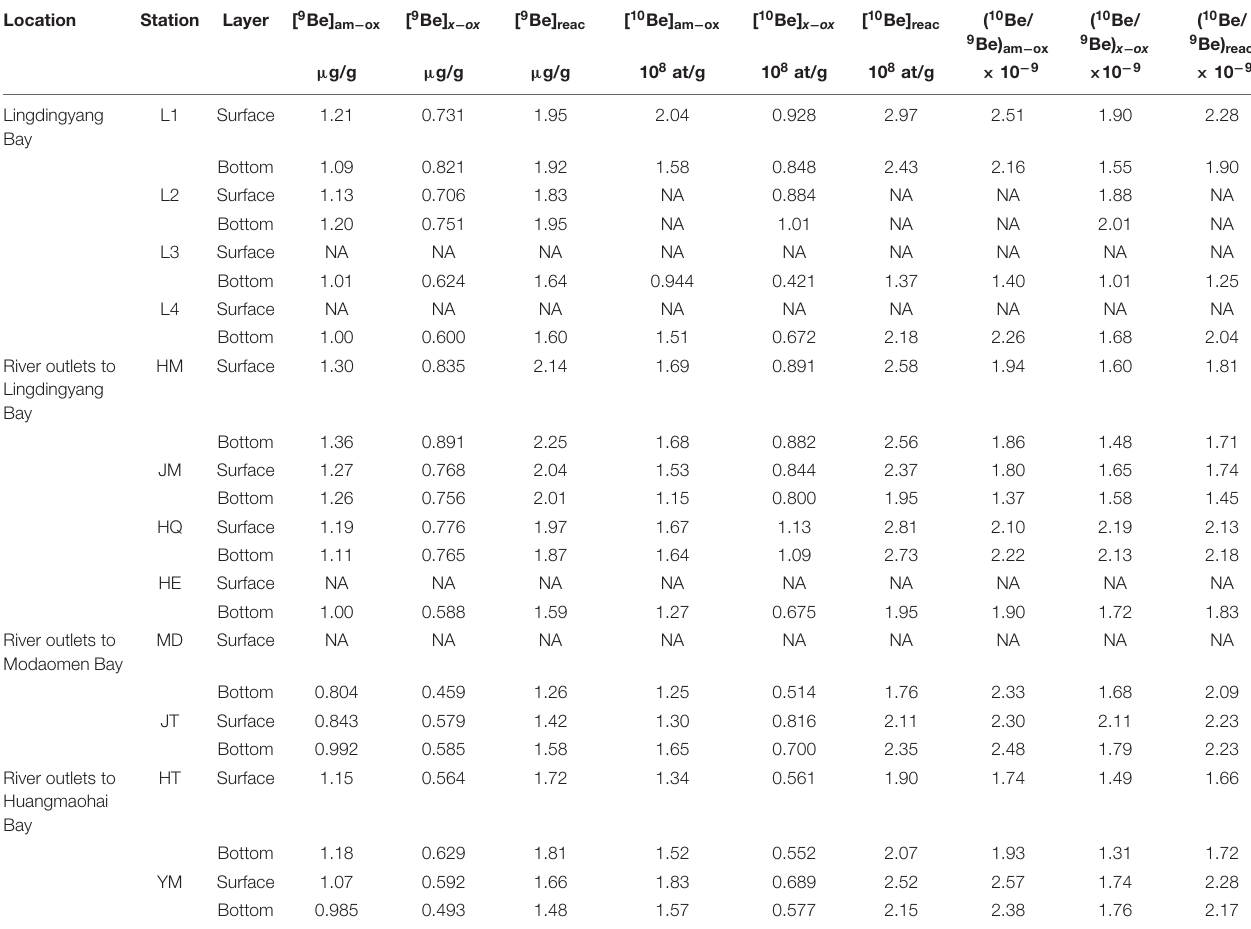
TABLE 2 | Beryllium isotope concentrations and 10 Be/ 9 Be ratios in reactive phases of suspended sediments. Location Station Layer [ 9 Be] am −